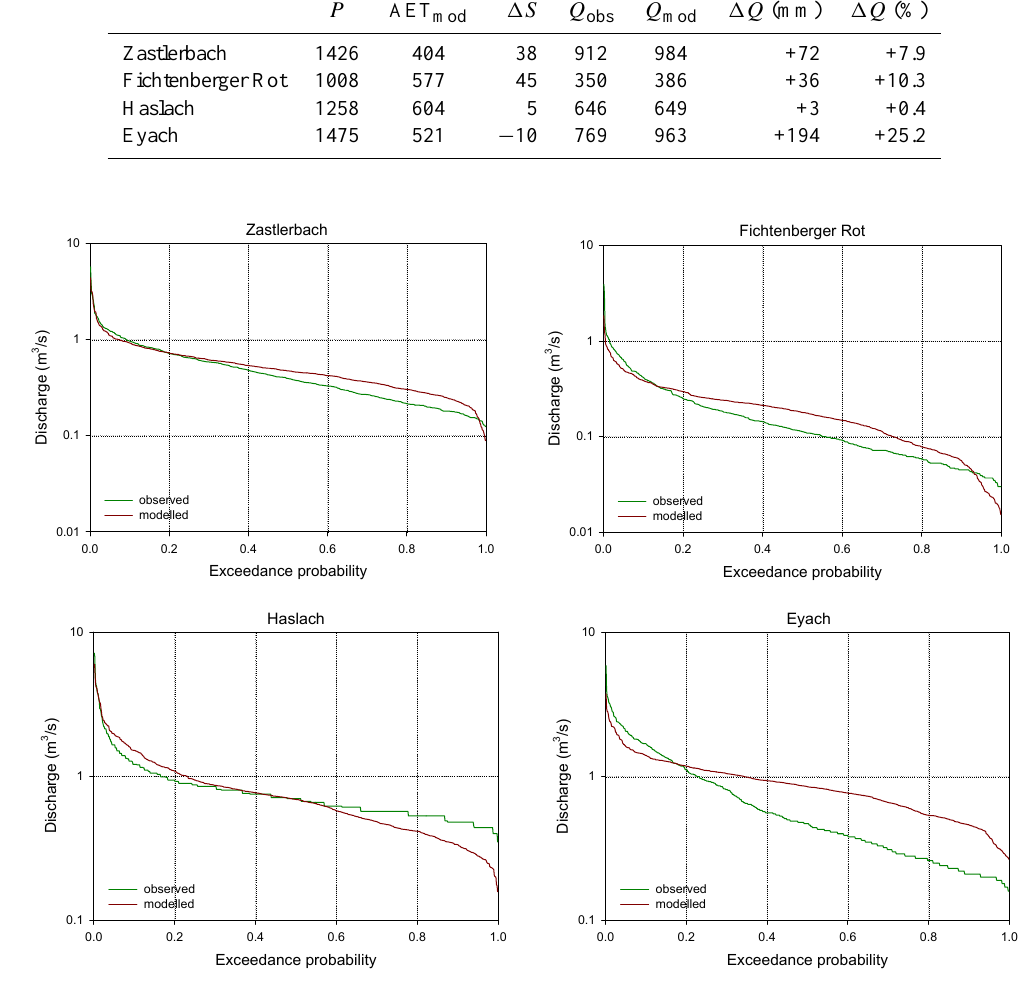
Fig. 6. Modelled and observed flow duration Figure 6. Modelled and observed flow duration curves. 2